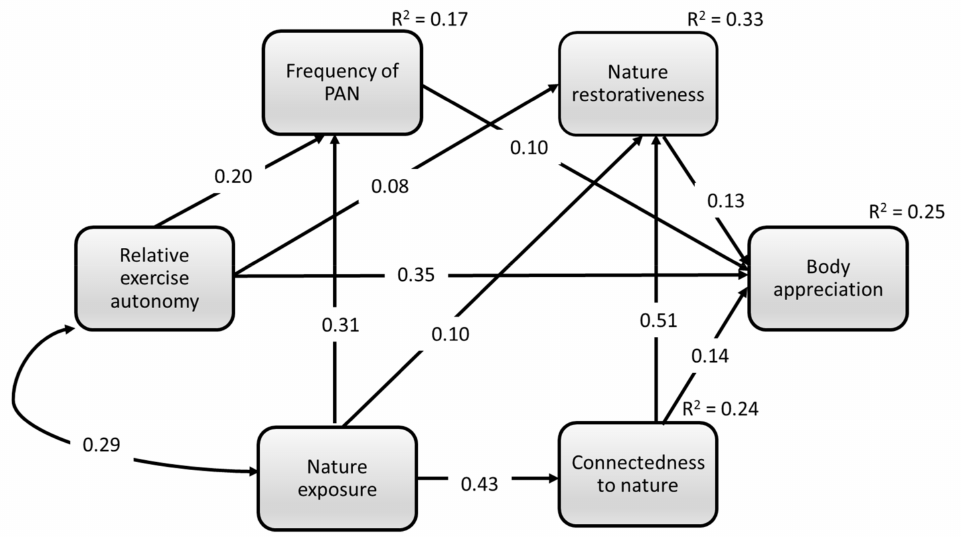
Figure 2. The final path model of the association between nature exposure and positive body image mediated by physical activity in nature (PAN), nature restorativeness and connectedness to nature with standardized estimates ( n = 924). Note. All regression coefficients are significant ( p < 0.01).